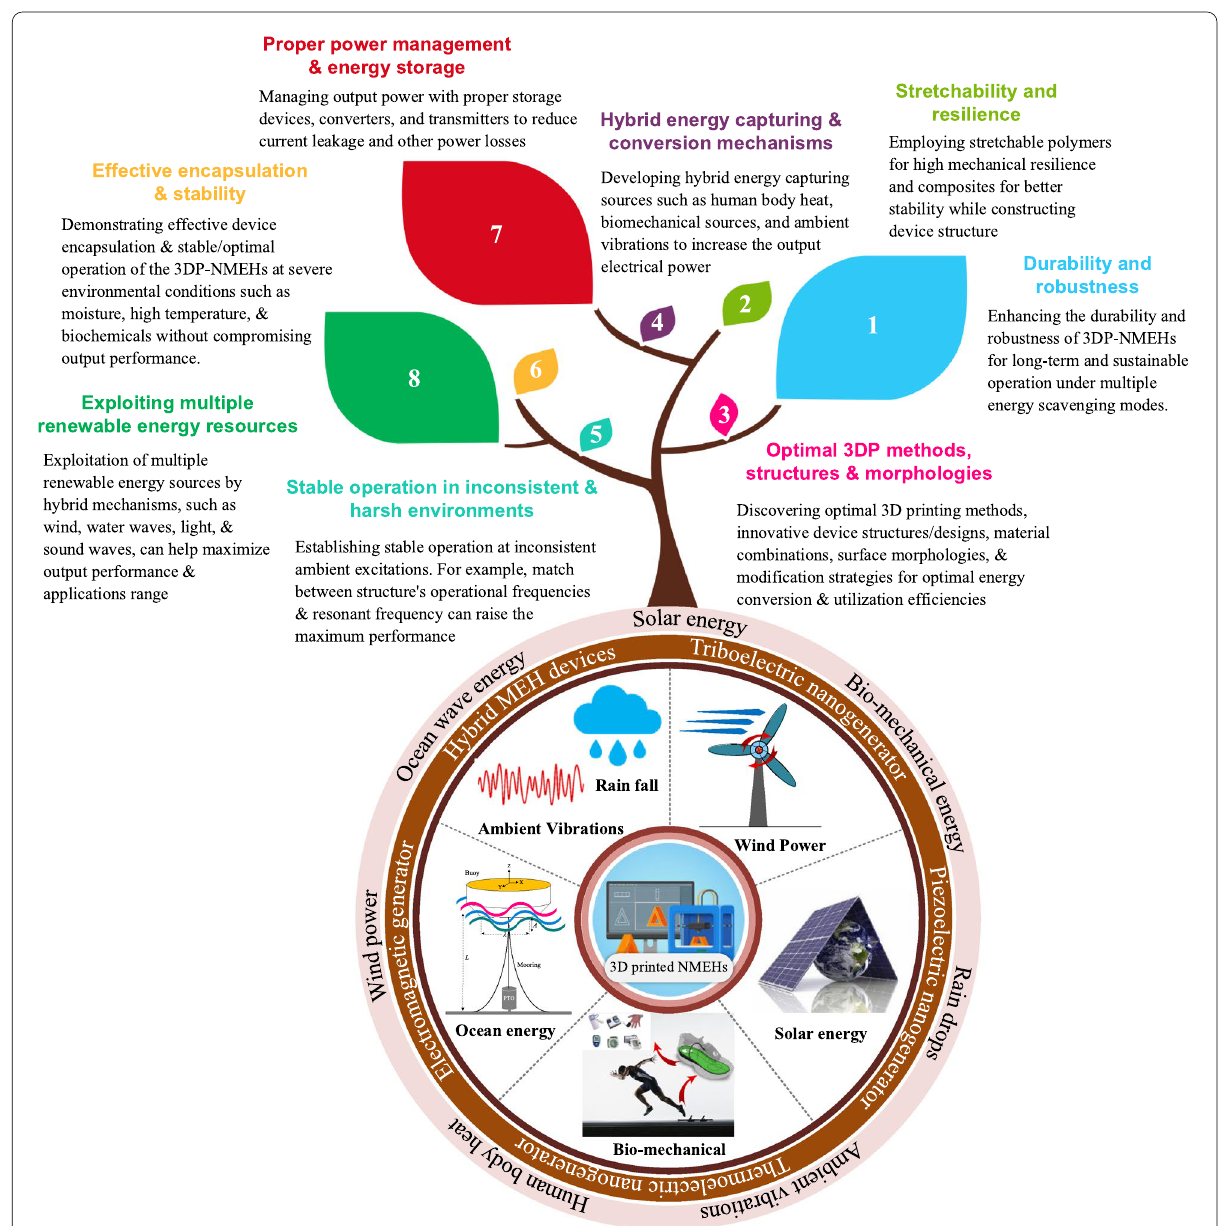
Fig. 19 Recommendations for future research to enhance 3DP-NMEH